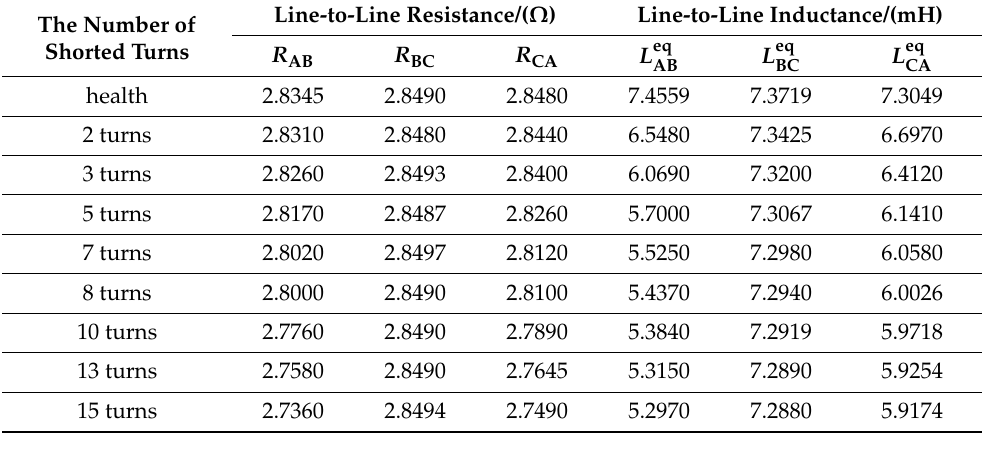
Table 2. Measured resistance and inductance.